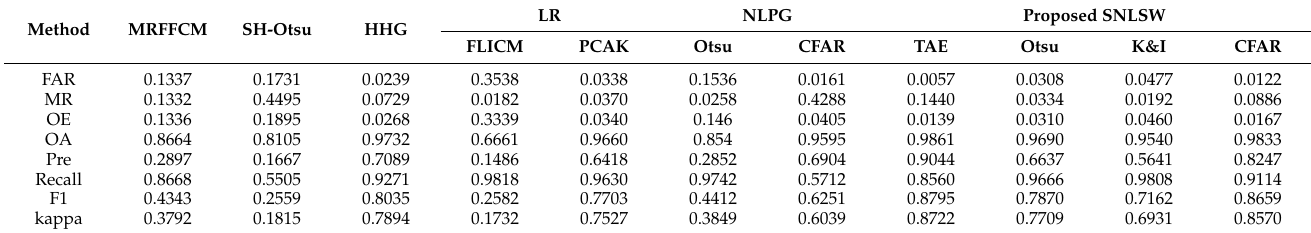
Table 2. Quantitative evaluation of the different methods on Dataset #2.